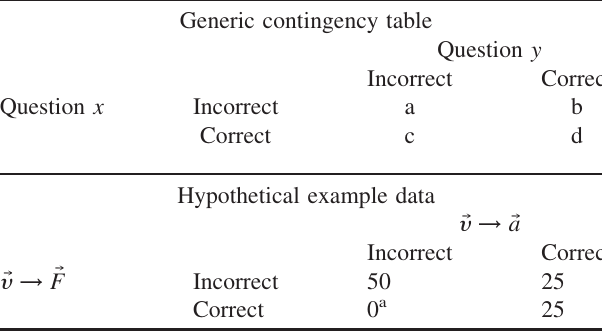
rule out or provide supporting evidence for the existence of